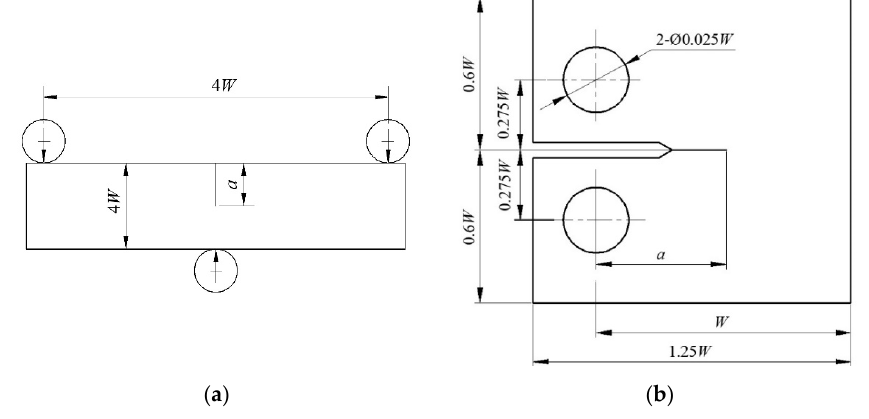
Table 1. Specimen sizes [13].